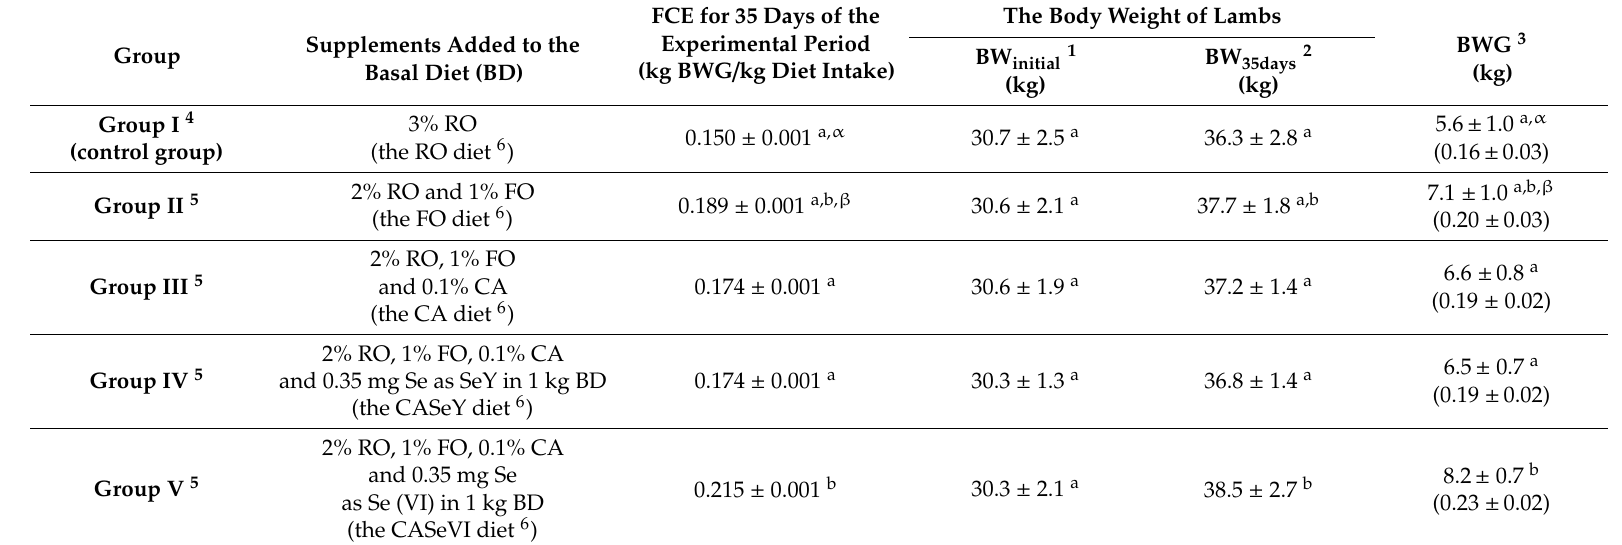
Table 1. The scheme of experiments carried out on lambs, additives added to the rapeseed oil (the RO diet, the control diet) and four experimental diets: fish oil diet (the FO diet), carnosic acid diet (the CA diet), carnosic acid selenium yeast diet (the CASeY diet) and carnosic acid selenium(VI) (the CASeVI diet), feed conversion e ffi ciency (FCE), body weight (BW), and body weight gain (BWG) of sheep